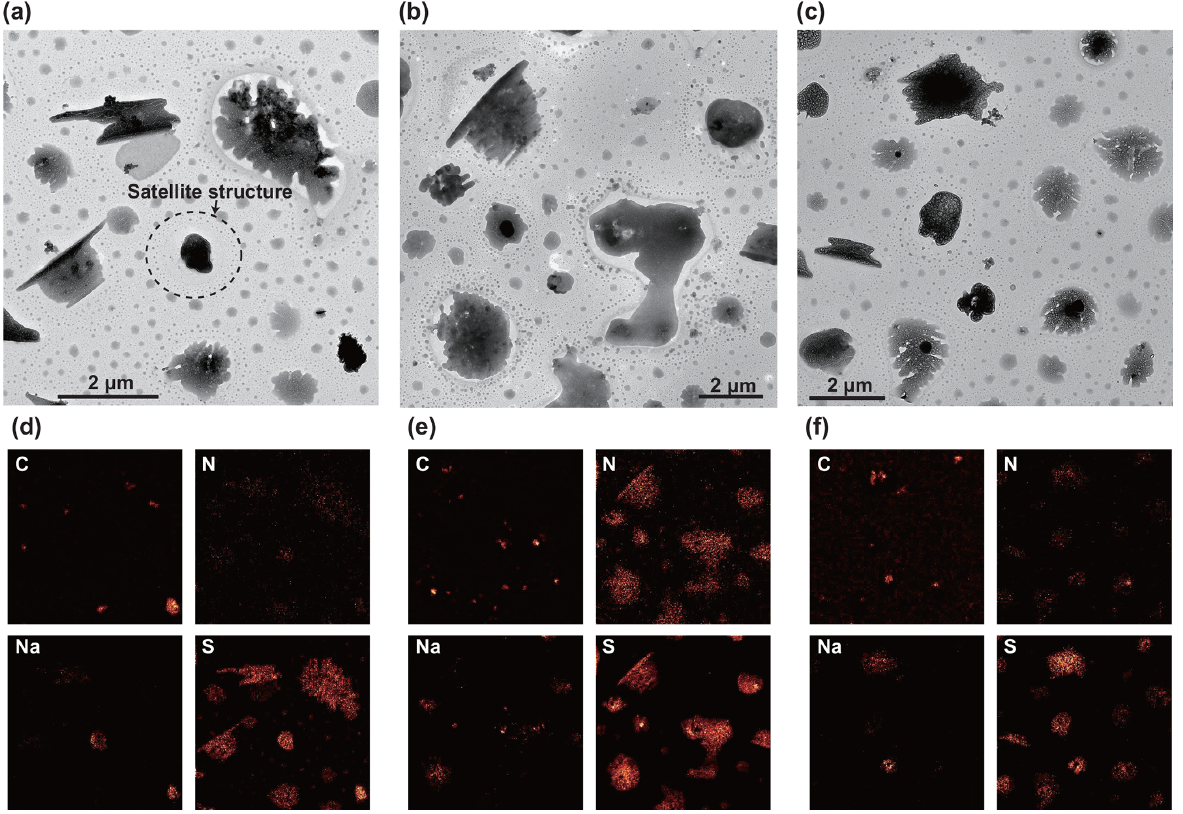
Figure 11. TEM and elemental mapping images of the sulfate particles. Top (a–c) : TEM images. Bottom (d–f) : elemental mapping images of the TEM areas for C, N, Na, and S. All particles were collected from 14:40–14:59UTC, 31 March 2018. Most particles mainly consist of sulfate. Some particles also include N and Na, suggesting that they are mixtures of ammonium sulfate and sodium sulfate. The carbon grains correspond to the internally mixed soot particles. Small droplets occur around relatively large sulfate particles, forming a satellite structure, as indicated in panel (a)